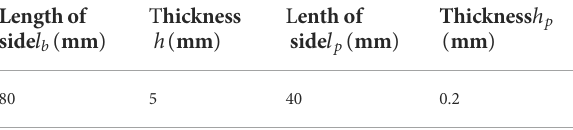
TABLE 2 Geometric parameters of the unit cell.